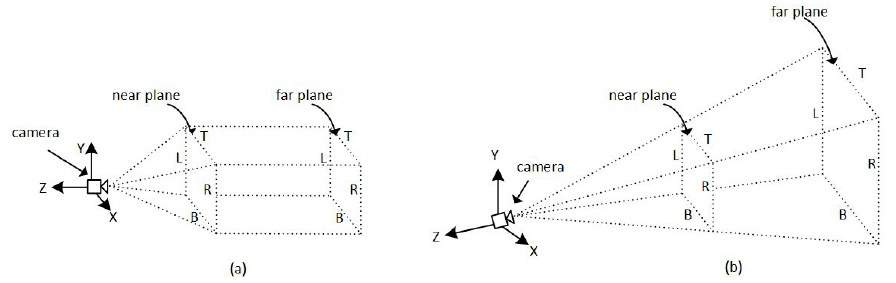
Figure 5. Types of view volume: ( a ) rectangular parallelepiped, ( b ) truncated pyramid also known as a frustum.